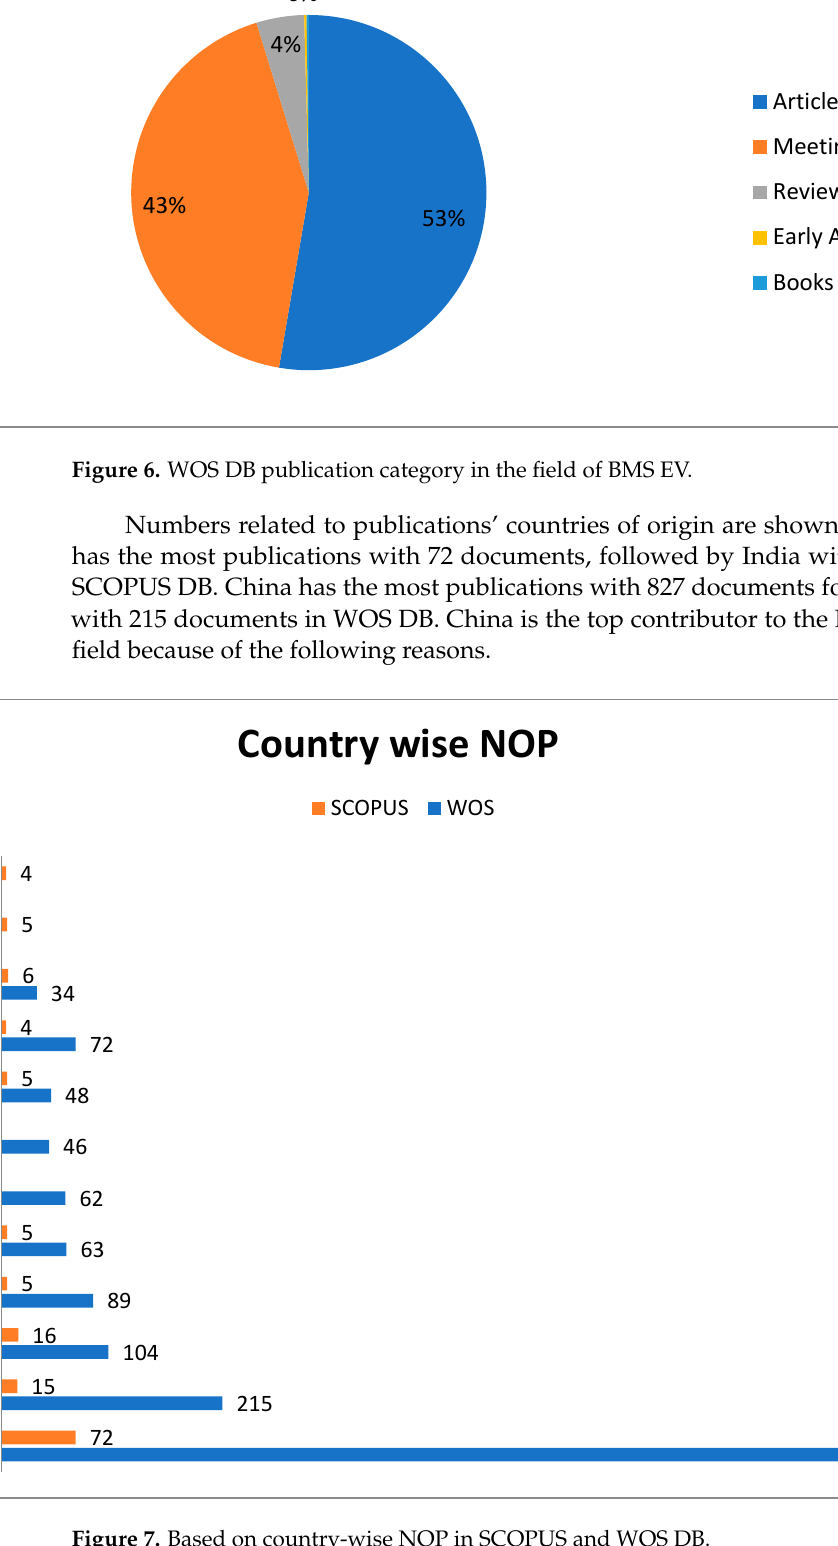
Figure 7. Based on country-wise NOP in SCOPUS and WOS DB.